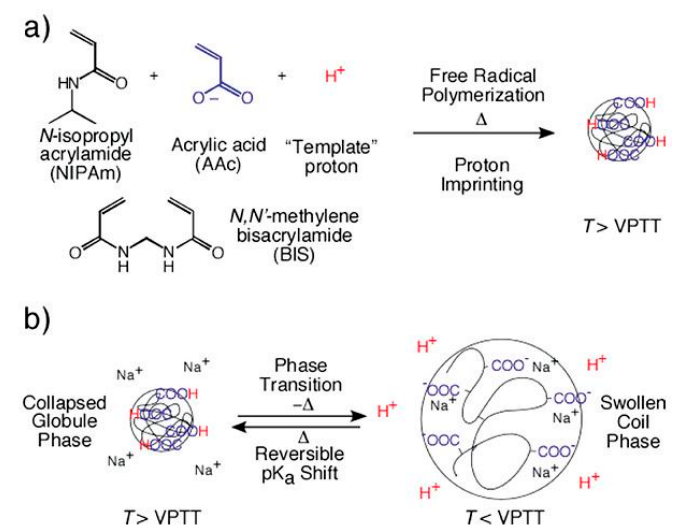
Figure 10. ( a ) Preparation of proton-imprinted NPs; ( b ) Reversible p K a shift of carboxylic acids in NPs triggered by the phase transition of NPs. Reprinted with permission from Reference 89. Copyright 2014, Wiley.